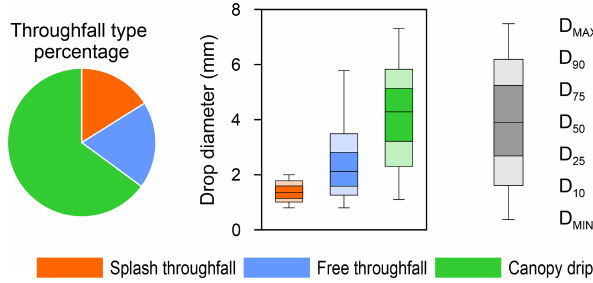
Figure 3. Throughfall type percentages (pie chart) and drop diame- ters for the three throughfall types (boxplots) for the 21 events stud- ied. The drop diameters are based on the mean of examined